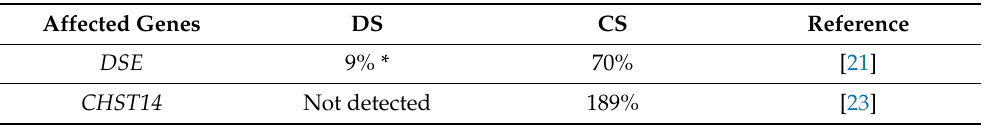
Table 3. Alteration of CS/DS disaccharides in the skin fibroblasts from patients with mutations in DSE and CHST14